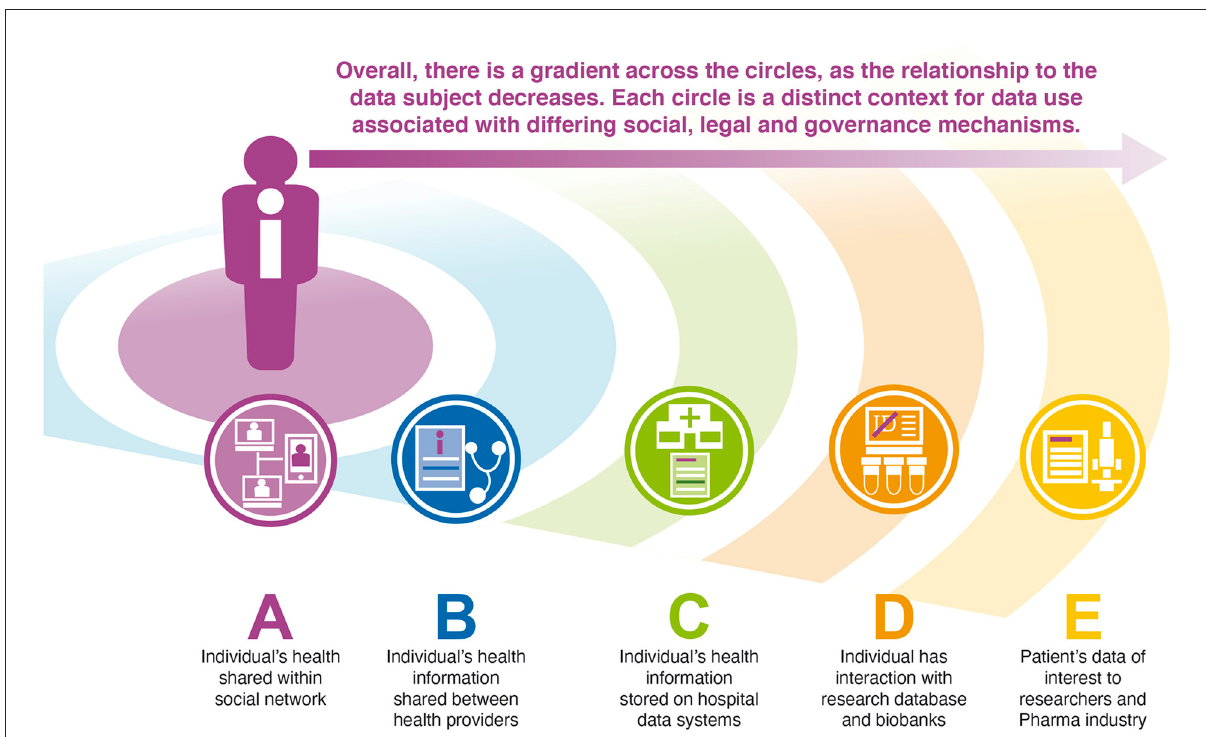
FIGURE1 The Concentric Circles View of a possible arrangement of data relationships for a single individual. In the proposed model, the initial circle (A) is the most intimate to the individual, and here involves the direct sharing of information within an individual’s social network. Data related to this individual are also shared between health providers (B) , stored on hospital data systems (C) and in research studies in which they participate (D) and used, in anonymised form by other researchers and the pharmaceutical industry, for example in drug discovery research (E) . Each of these contexts involves a distinct social, legal, ethical and technical